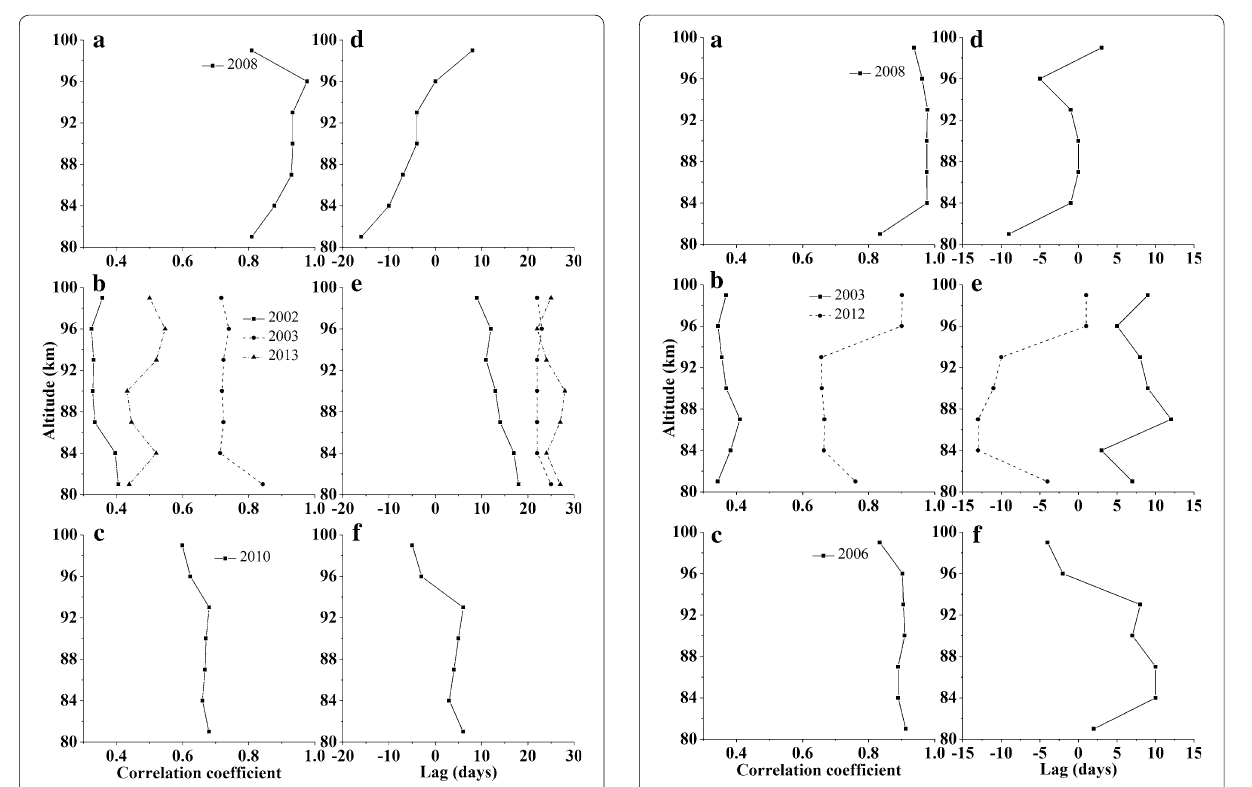
Fig. 6 Same as shown in Fig. 5, but here it is for the zonal semidiurnal tide